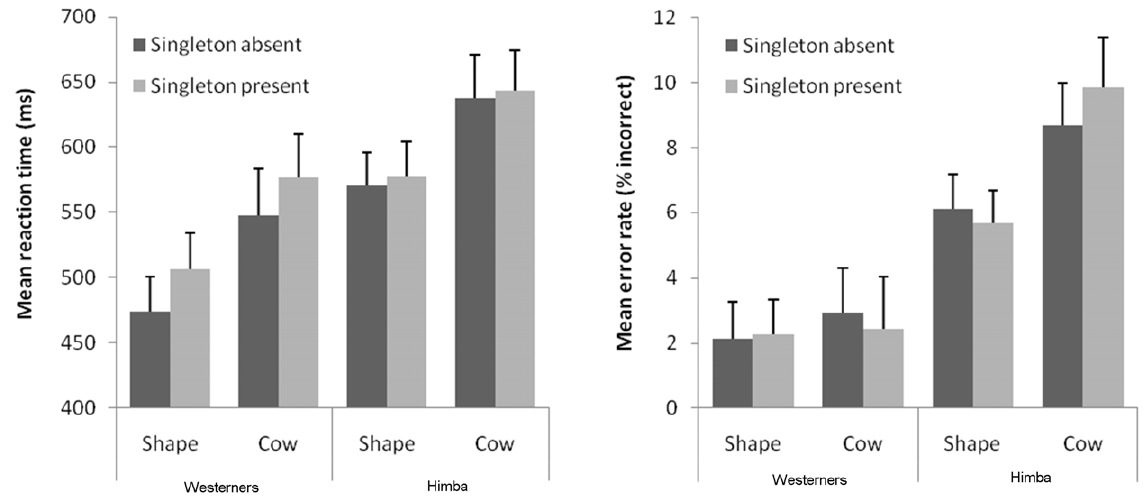
Figure 4. Results for Experiment 2. Reaction times (left panel) and error rates (right panel) are presented for Westerners and Himba as a function of singleton type and presence. Error bars represent standard error.